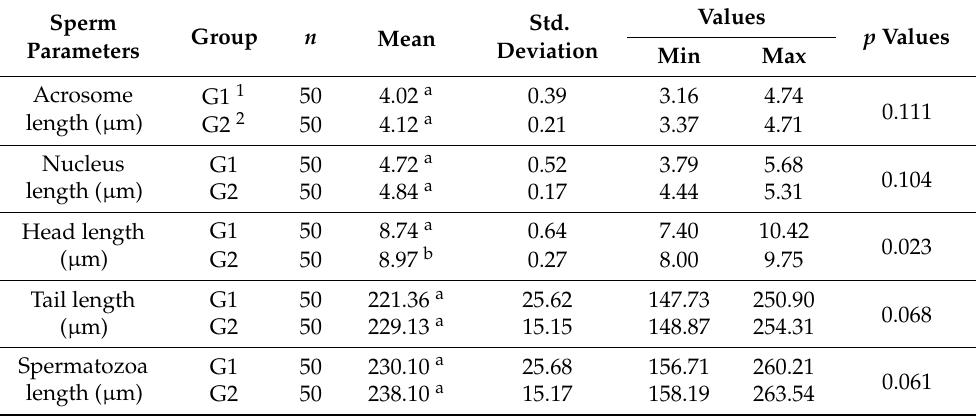
Table 2. Results of morphometric analysis of honey bee drone spermatozoa.